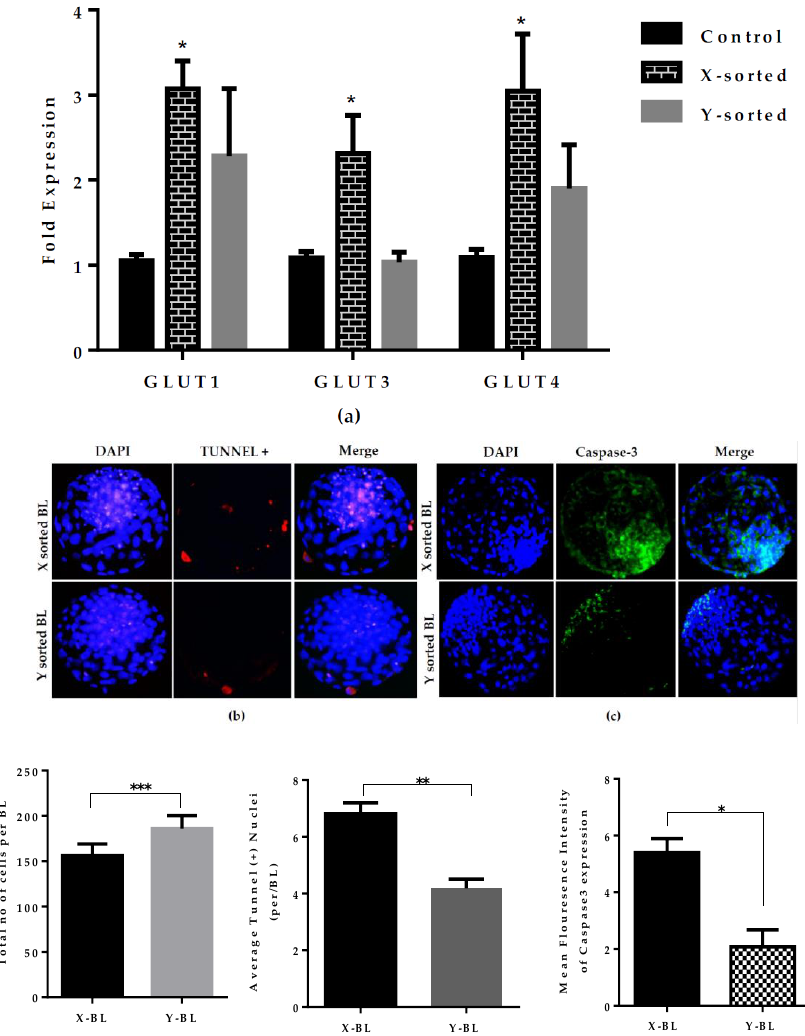
Figure 4. Differences in cell metabolism and apoptosis level on the quality and development kinetics of X- and Y-sorted BL. ( a ) Relative mRNA level of GLUT1, GLUT3, GLUT4 in control, X-, and Y-sperm generated day seven BL groups. ( b ) Fluorescence microscope image of TUNEL-positive cells (red) and DAPI (4,6-diamidino-2-phenylindole) (blue) shown in X- and Y-BL at day seven. White arrows indicate the apoptotic cells in nuclei. ( c ) Representative fluorescent image showing Caspase-3 expression in X- and Y-BL. Graphical data represent the quantification of fluorescent images of X- and Y-BL groups. Data in the bar graphs represent the means ± SEM from three independent sets of experiments including n = 20 BLs per group in each replicate. * p < 0.05; ** p < 0.01; *** p < 0.001. Original magnification 100×.